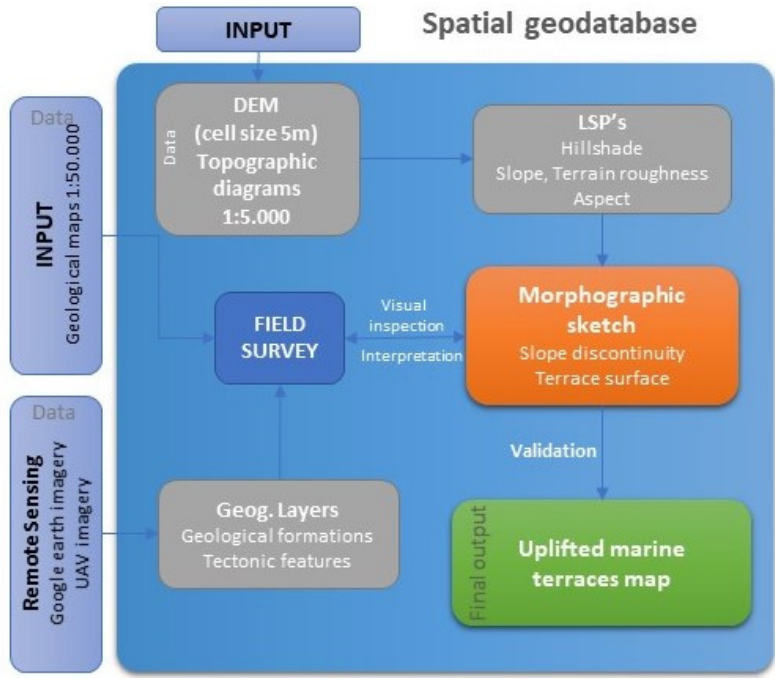
Figure 3. Workflow diagram of the main steps of the terrace-mapping methodological